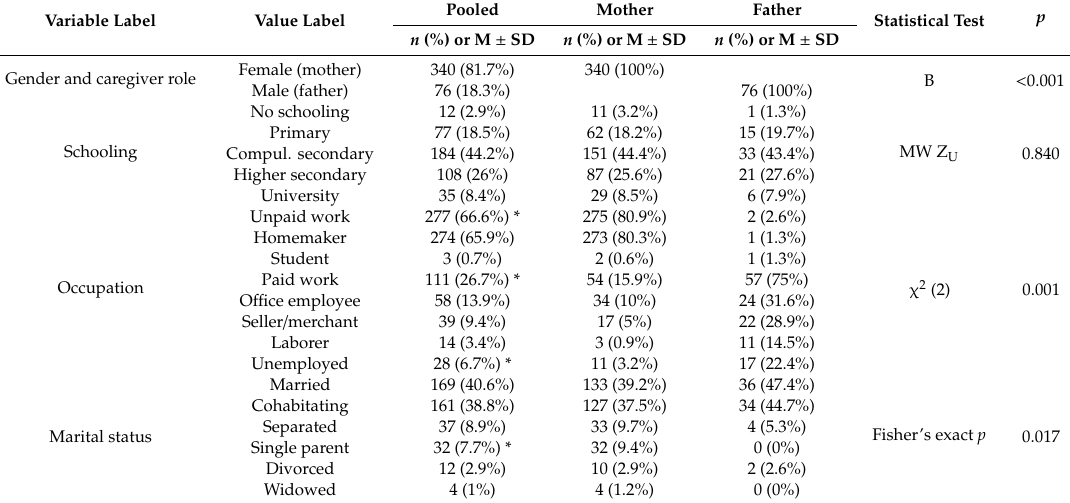
Table 1. Summary statistics of the parents’ sociodemographic